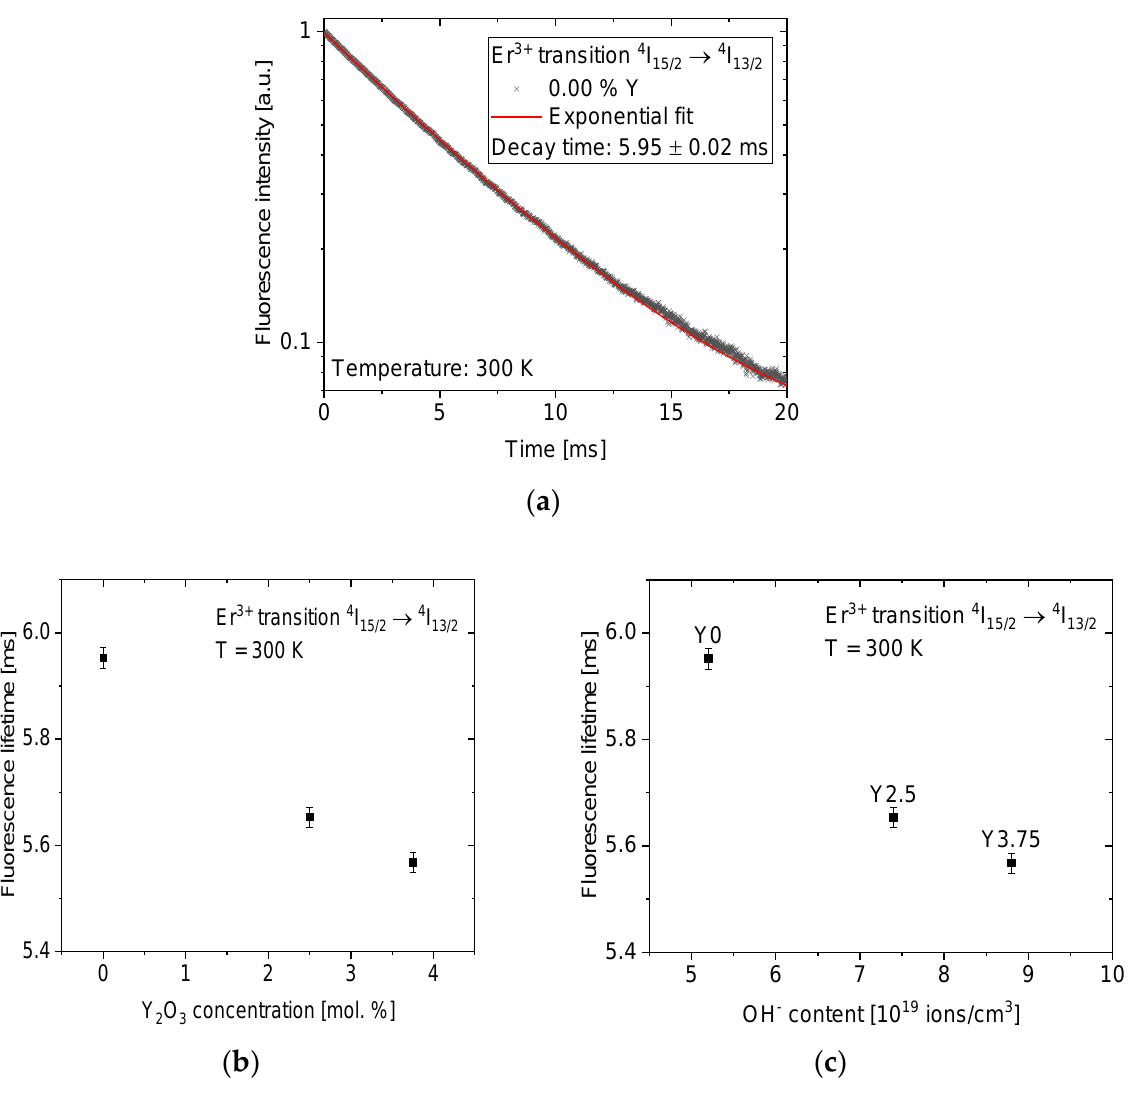
Figure 8. The fluorescence decay curve of the glass Y 0 , taken as an example ( a ). The dependence of fluorescence lifetime of the glasses on Y 2 O 3 concentration ( b ) and on OH − content ( c ).